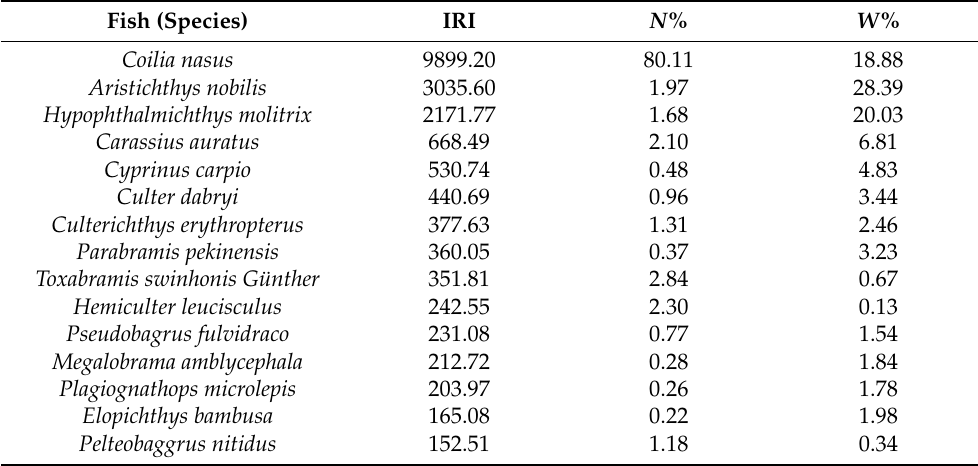
Table 5. The composition of dominant species and important species of fish in the ecological restora- tion area of Gehu Lake in